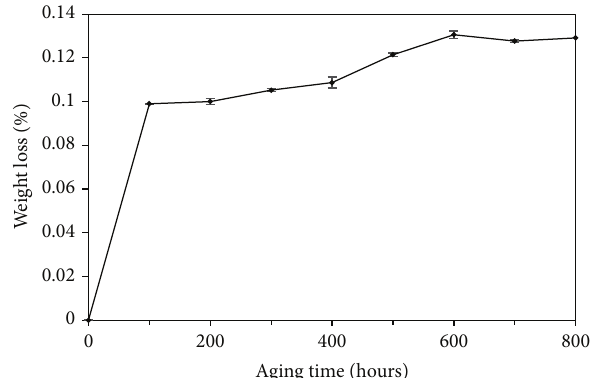
Figure 9: FTIR spectra of EHG250-68-37 composite sample in the fingerprint (2000–400 cm −1 ) domain (initially and after 800 h thermooxidative aging).